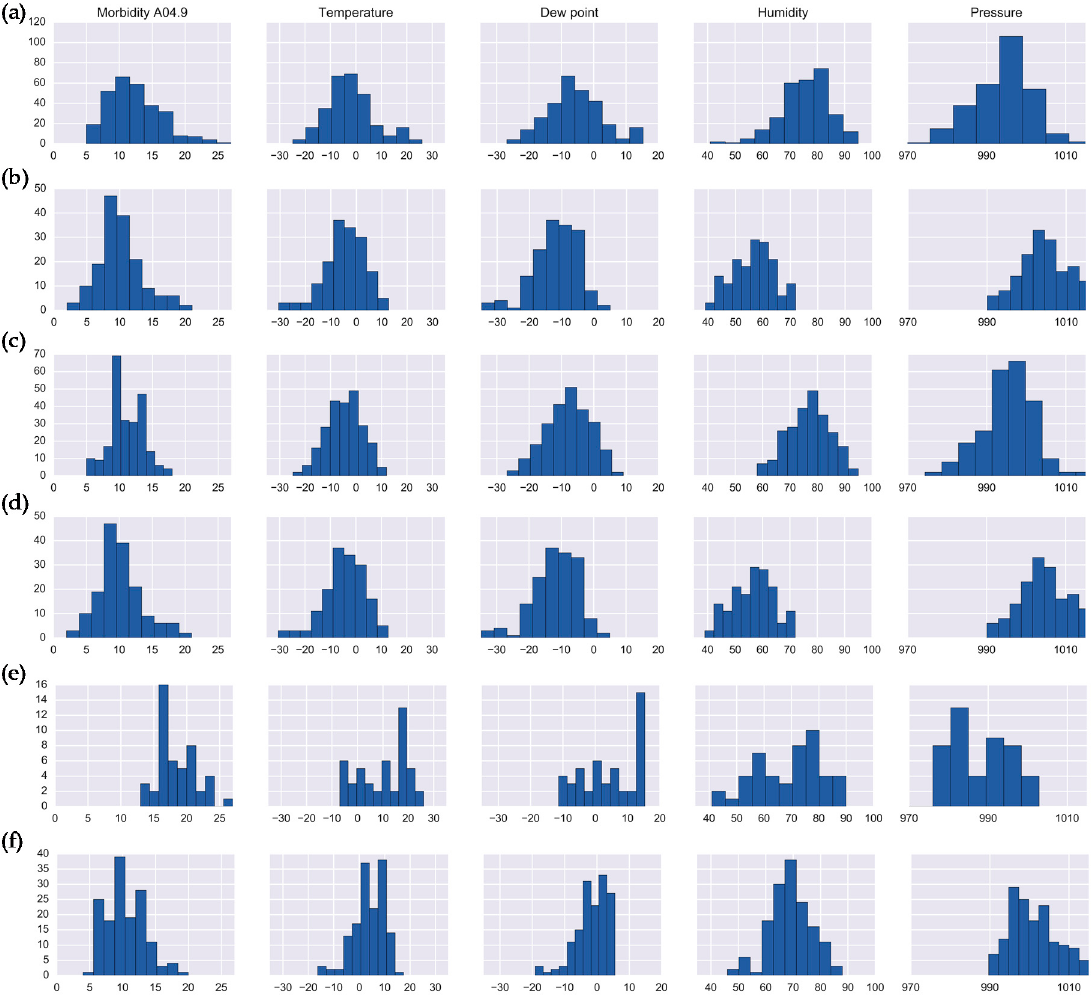
Figure 6. Histograms of enteritis daily counts and meteorological characteristics for: ( a ) Cluster 2 (Set 1); ( b ) Cluster 8, (Set 1); ( c ) Cluster 7 (Set 2); ( d ) Cluster 8 (Set 2); ( e ) Cluster 10 (Set 2); ( f ) Cluster 11 (Set 2 ).